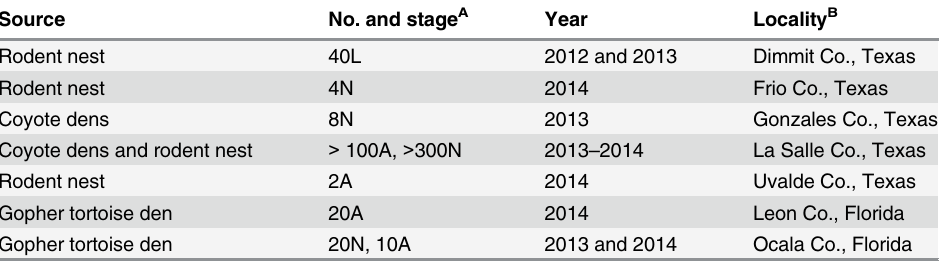
Table 2. Collection summary of O . turicata in Texas and